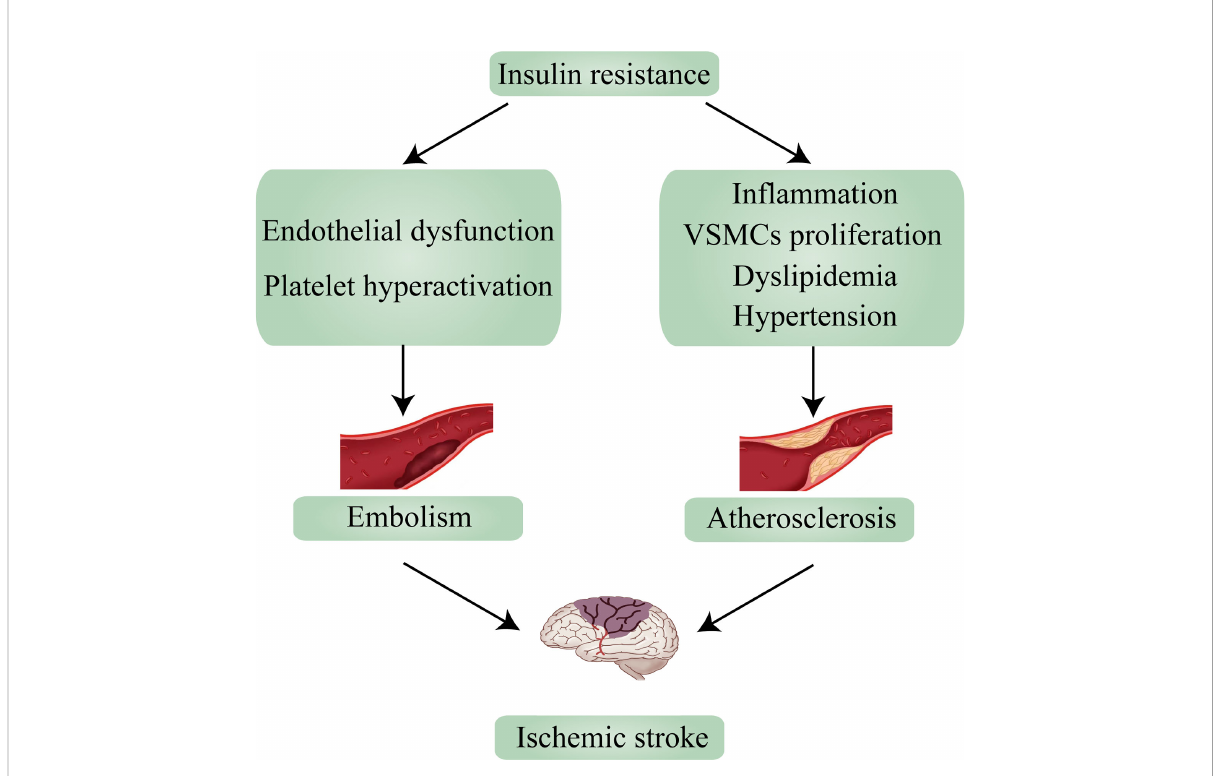
FIGURE 2 Insulin resistance leads to ischemic stroke via embolism and atherosclerosis. VSMCs, vascular smooth muscle